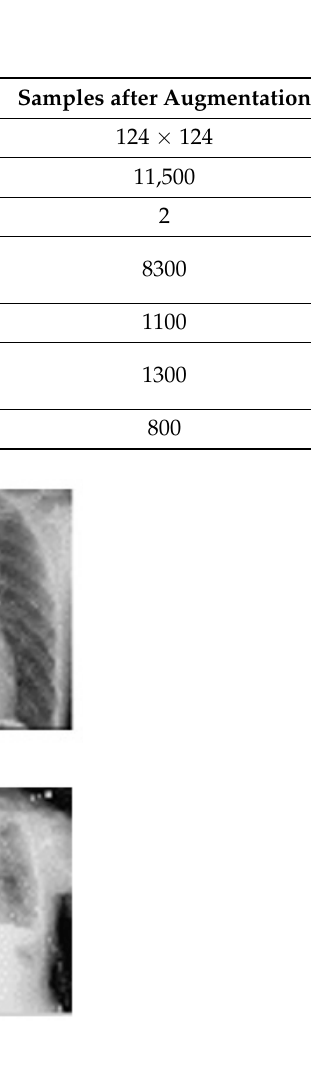
Figure 3. Samples of X-ray images: ( a ) pneumothorax affected and ( b ) pneumothorax not affected. Table 2. Dataset parameters.